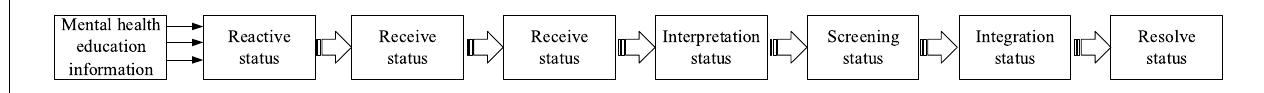
FIGURE 1 | Acceptance state of big data network of ’the mental health education of college